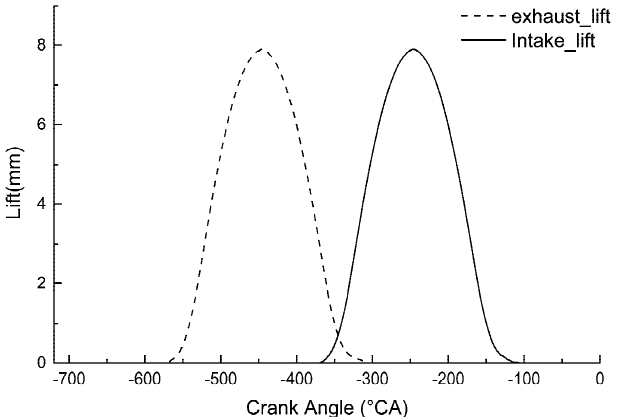
Figure 3. Lift curves of the intake valve and exhaust valve.